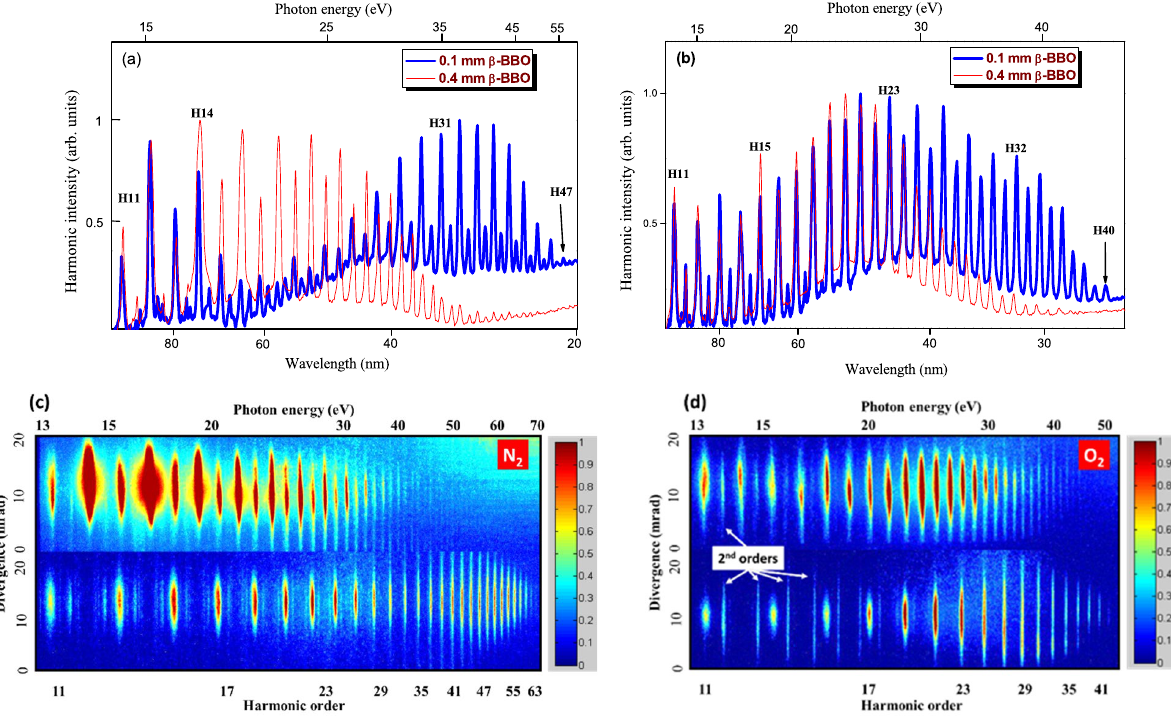
Figure 4. Normalized intensities of harmonics generated during two-color field of ( a ) nitrogen and ( b ) oxygen using BBOs of different thickness (0.1 mm: thick blue curves; 0.4 mm: thin red curves). The harmonics were obtained at E ω + E 2ω = 470 µJ. Raw images of harmonics generated in ( c ) N 2 and ( d ) O 2 using 1030 nm pulses (bottom panels in ( c ) and ( d )) and (1030 nm + 515 nm pulses) (upper panels in ( c ) and ( d )). The total energy of driving pulses was equal to 520 and 470 **µJ for the experiments with N 2 and O 2 gases, respectively. 2nd order spectral lines are marked with white arrows in Fig. 4d. These lines correspond to the second-order emission of strong higher order harmonics from the 23rd to the 35th orders.